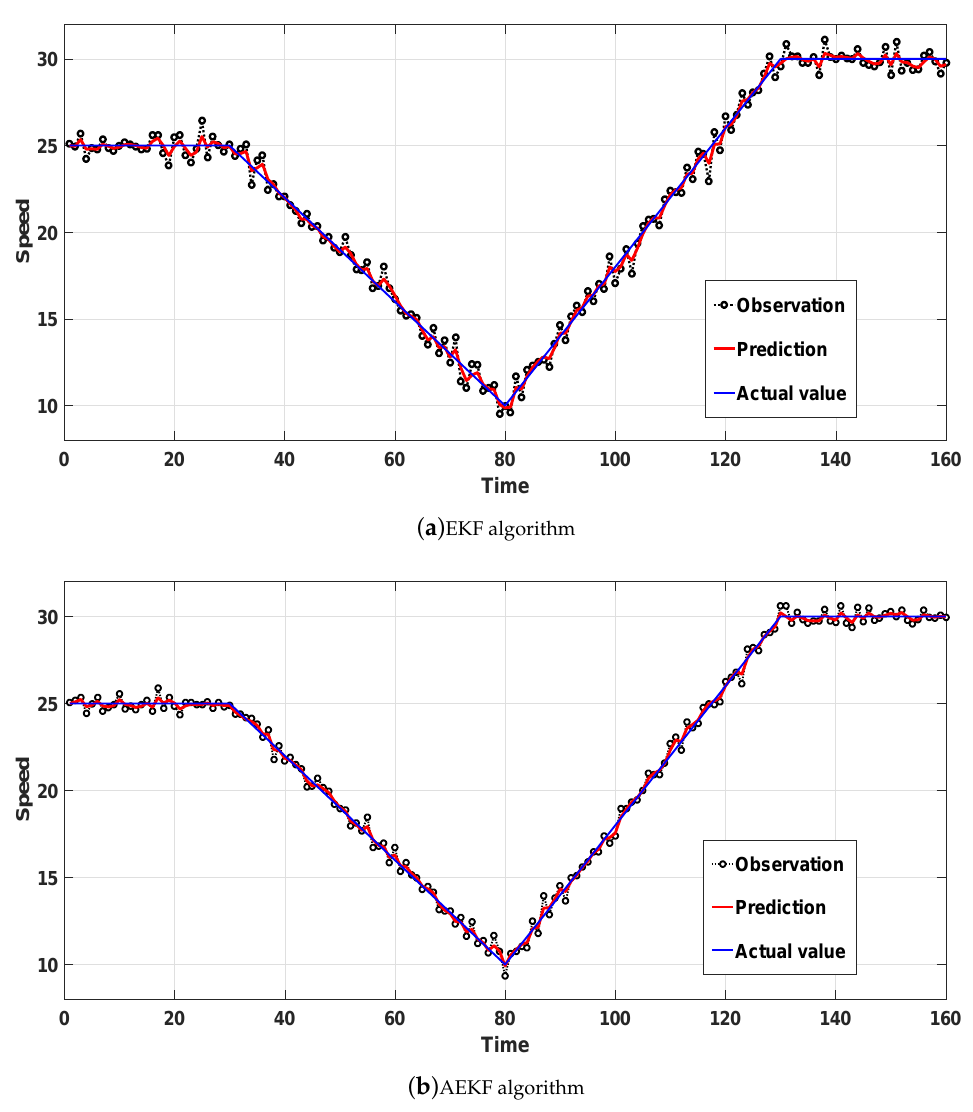
Figure 5. Speed prediction effect in the normal